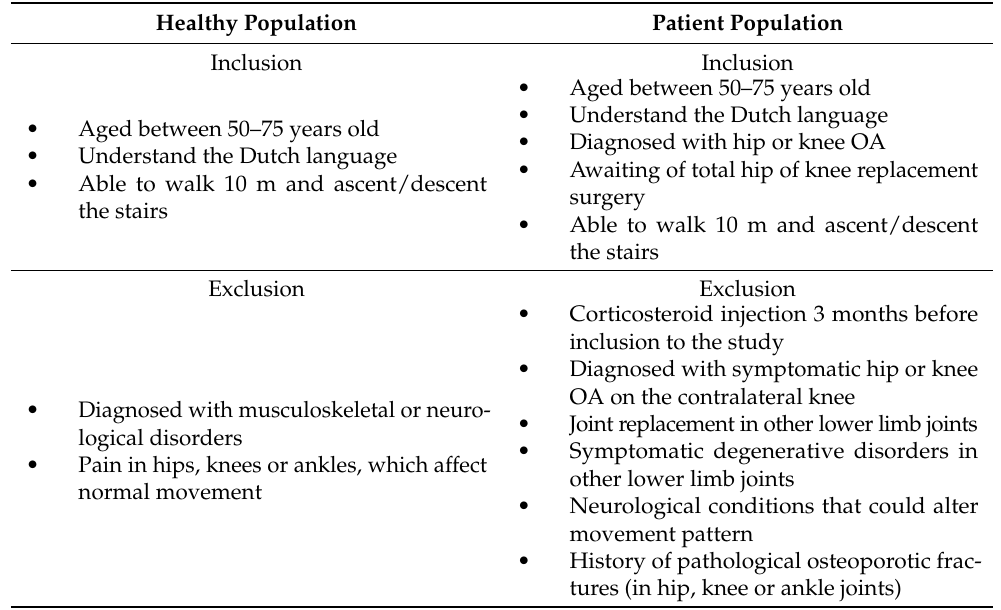
Table 1. Inclusion and exclusion criteria for the